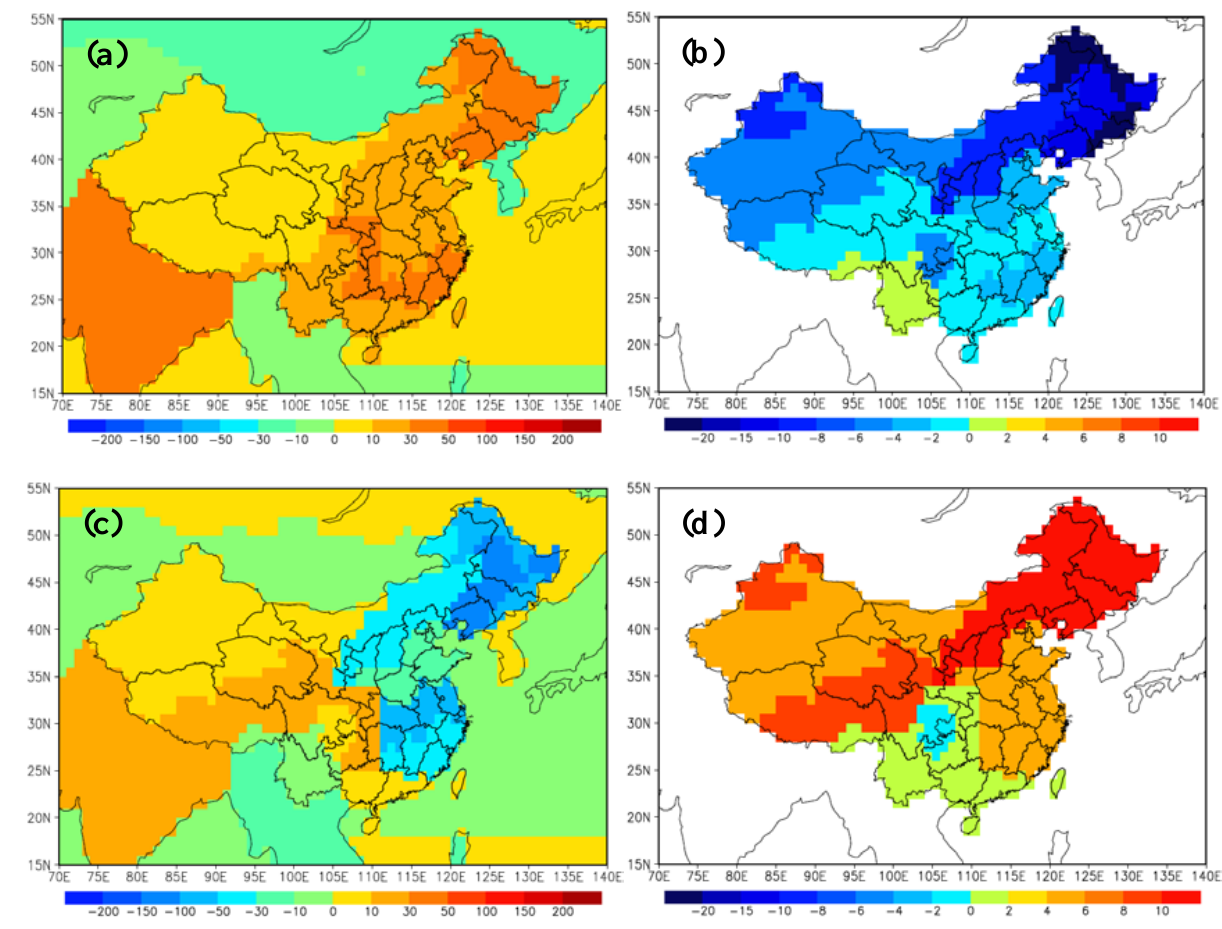
Fig. 8. Anomaly of land sinks ( a , c , gCm − 2 yr − 1 , positive indicates sink decreases; negative indicates sink increases) and anomalous per- centage of annual mean temperature ( b , d , %, positive indicates temperature increases; negative indicates temperature decreases) in 2005 ( a and b ) and 2007 ( c and d